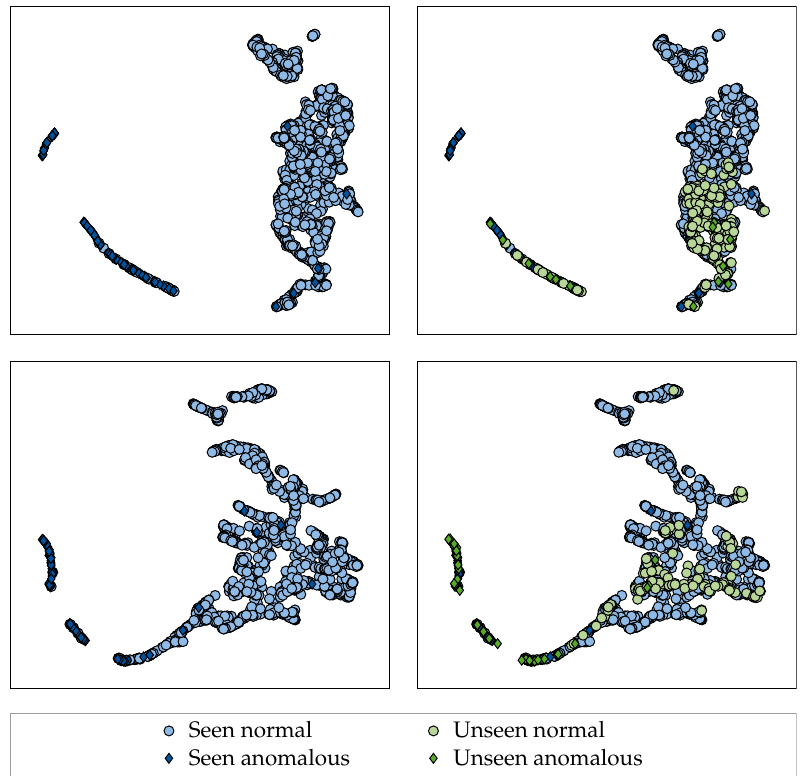
Figure 7. Two-dimensional UMAP embeddings of a pre-trained EfficientNet-B0 fine-tuned with the HSC objective under the application of AugMix in a LOO manner on Dataset B for fabric 23 (top) and fabric 12 (bottom). Left shows the embedding for the test set of the large-scale dataset used for fine-tuning, whereas right additionally shows the held out fabric projected into the same